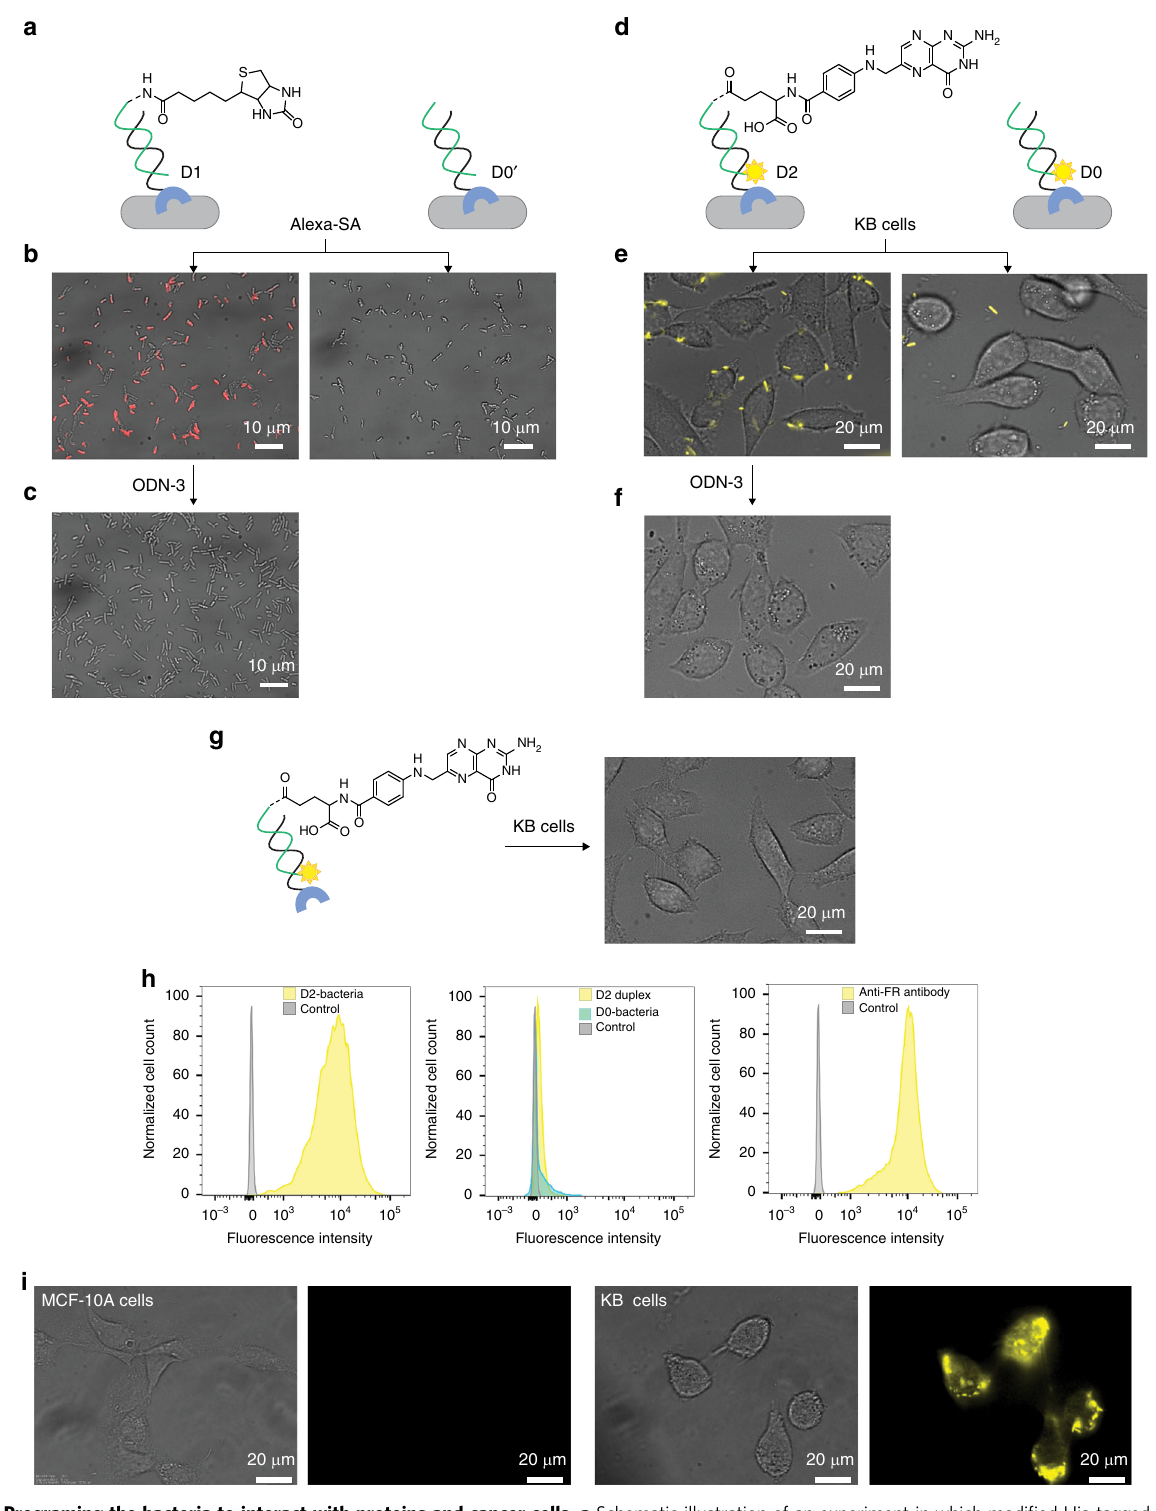
Fig. 4 Programing the bacteria to interact with proteins and cancer cells. a Schematic illustration of an experiment in which modi fi ed His-tagged bacteria were treated with Alexa 647-modi fi ed streptavidin (Alexa-SA). Left: Bacteria modi fi ed with a D1 duplex generated from ODN-1 and biotin-ODN-2. Right: Bacteria modi fi ed with a D0 ’ duplex that lacks biotin. b The resulting images (merged bright- fi eld and fl uorescence). c Images recorded following the incubation of the bacteria bound to Alexa-SA with ODN-3. d Schematic illustration of an experiment in which modi fi ed His-tagged bacteria were incubated with KB-cells. Left: Bacteria decorated with a D2 duplex consisting of ODN-1 and TAMRA-labeled folate-ODN-2. Right: Bacteria decorated with a D0 duplex that lacks the folate group. e The resulting images. f Images obtained after treating the bacteria that are bound to KB cells with ODN-3. g Incubating KB-cells with the D2 duplex (in the absence of bacteria) did not lead to fl uorescence labeling of the KB-cell. h Representative fl ow cytometry histograms of KB cells before (gray) and after (yellow/cyan) treatment with: (left) D2-modi fi ed bacteria (16×10 8 cells/ml), (middle) D2 alone or D0-modi fi ed bacteria (500nM), and (right) anti-FR antibody (0.31 μ g/ml). i Bright fi eld and fl uorescent images of healthy MCF-10A cells (left) and cancerous KB cells (right) treated with the D2-modi fi ed